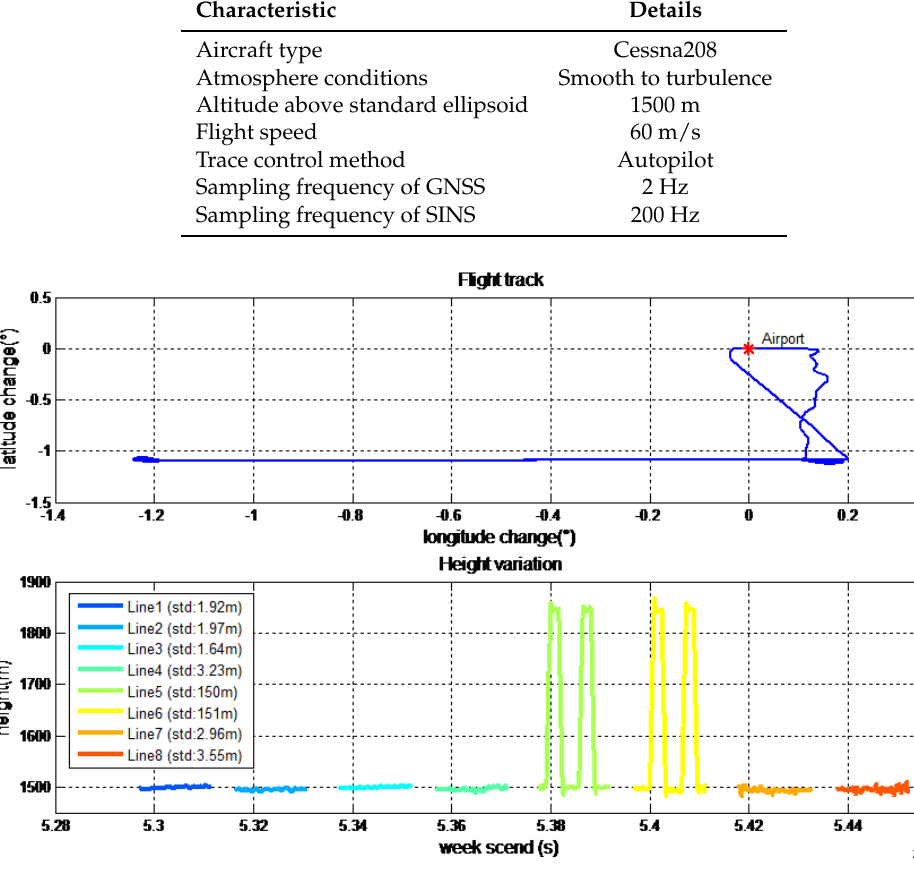
Figure 11. Path of flight test and height variation in